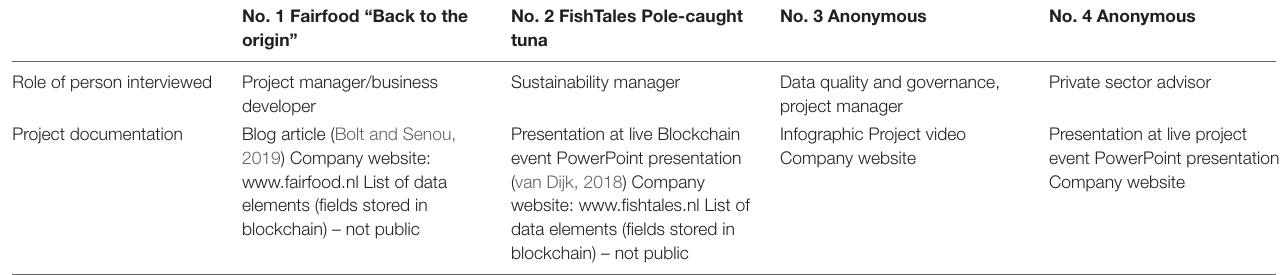
TABLE 3 | Case data sources.